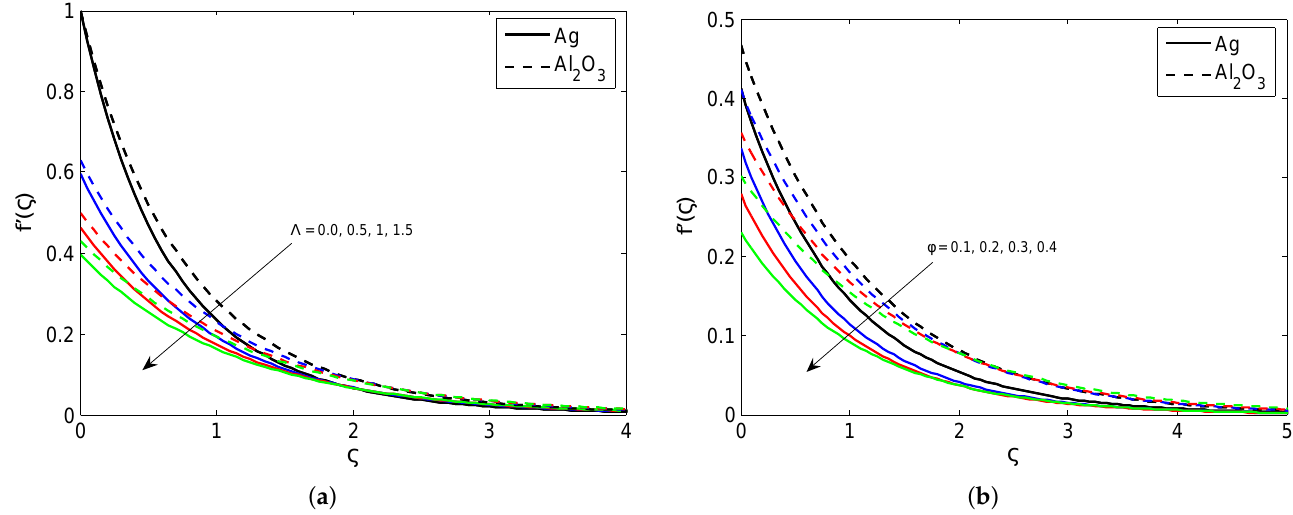
Figure 3. The variation of f (cid:48) ( ς ) in relation to ( a ) Λ and ( b ) φ .